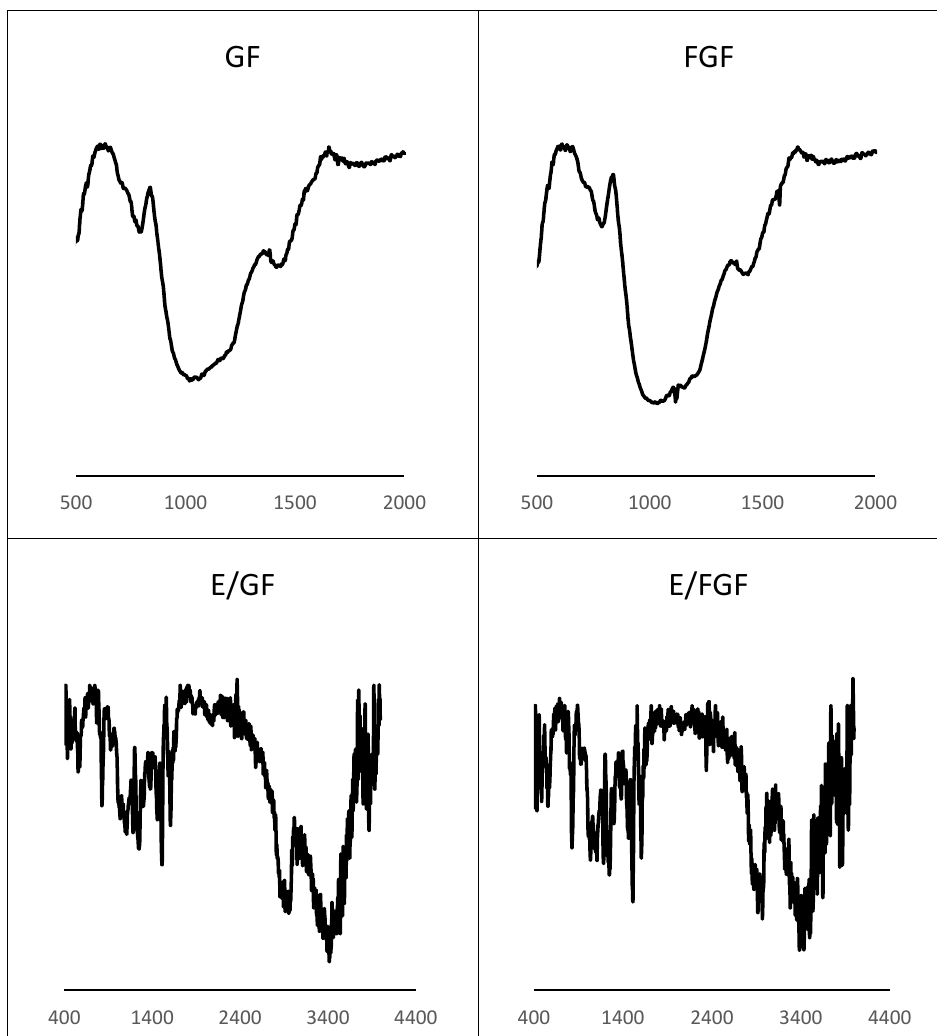
Figure 1. FTIR spectra of GF, FGF, E/GF, and E/FGF.